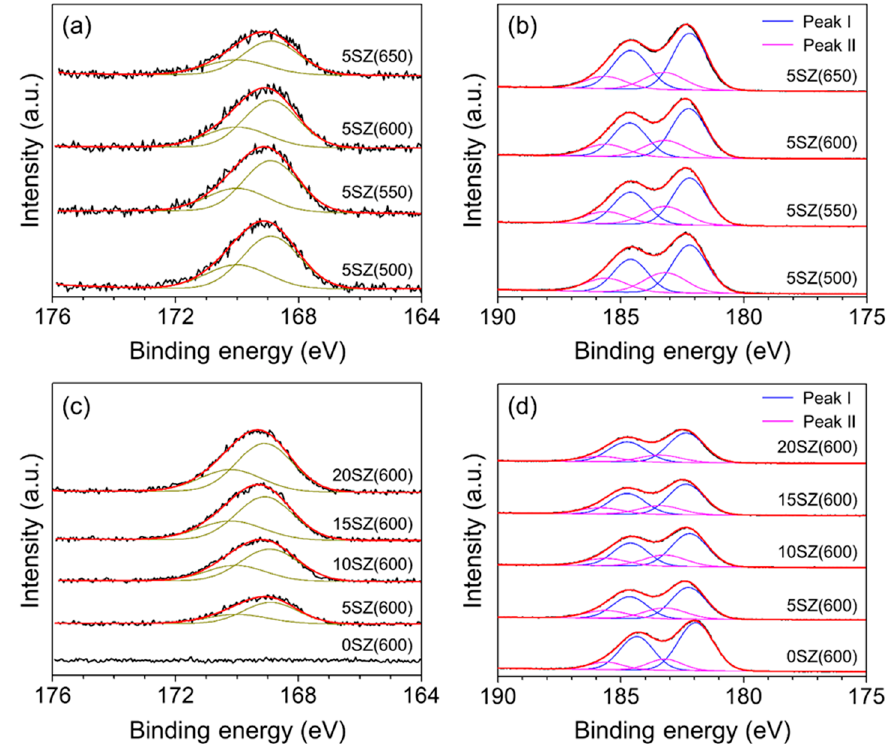
Figure 4. Deconvoluted XPS spectra of S 2p 3/2 ( a , c ) and Zr 3d 5/2 ( b , d ) over x SZ( y ) catalysts. Table 3. Binding energies of the deconvoluted peaks from S 2p 3/2 , Zr 3d 5/2 , and O 1s XPS